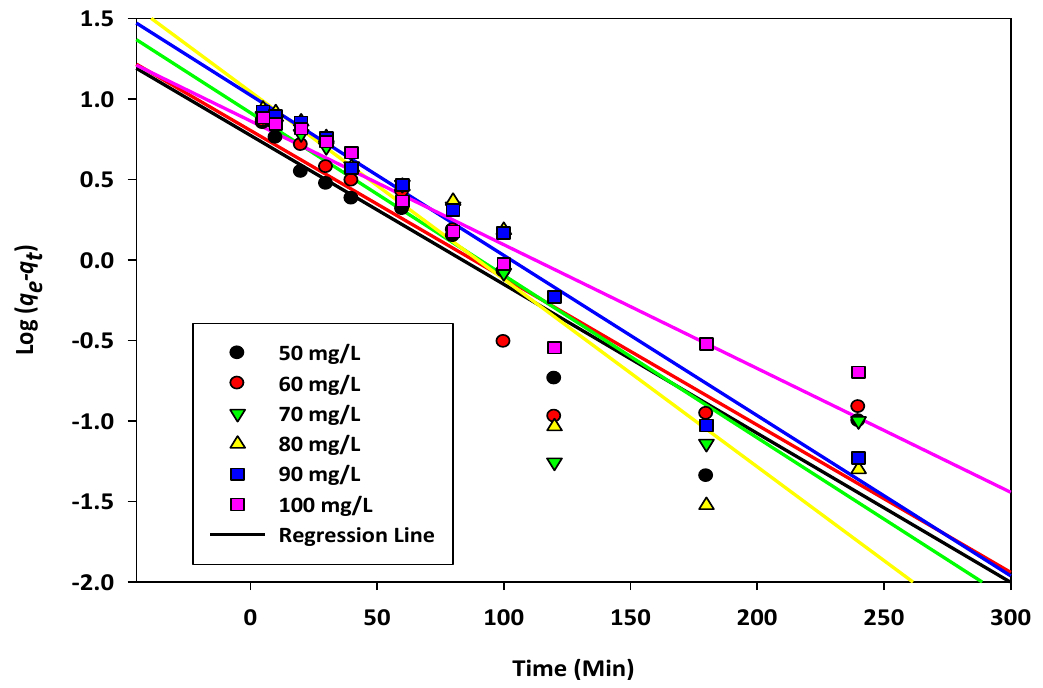
Figure 3. Pseudo first order kinetics of copper, Cu(II) cation sorption onto activated